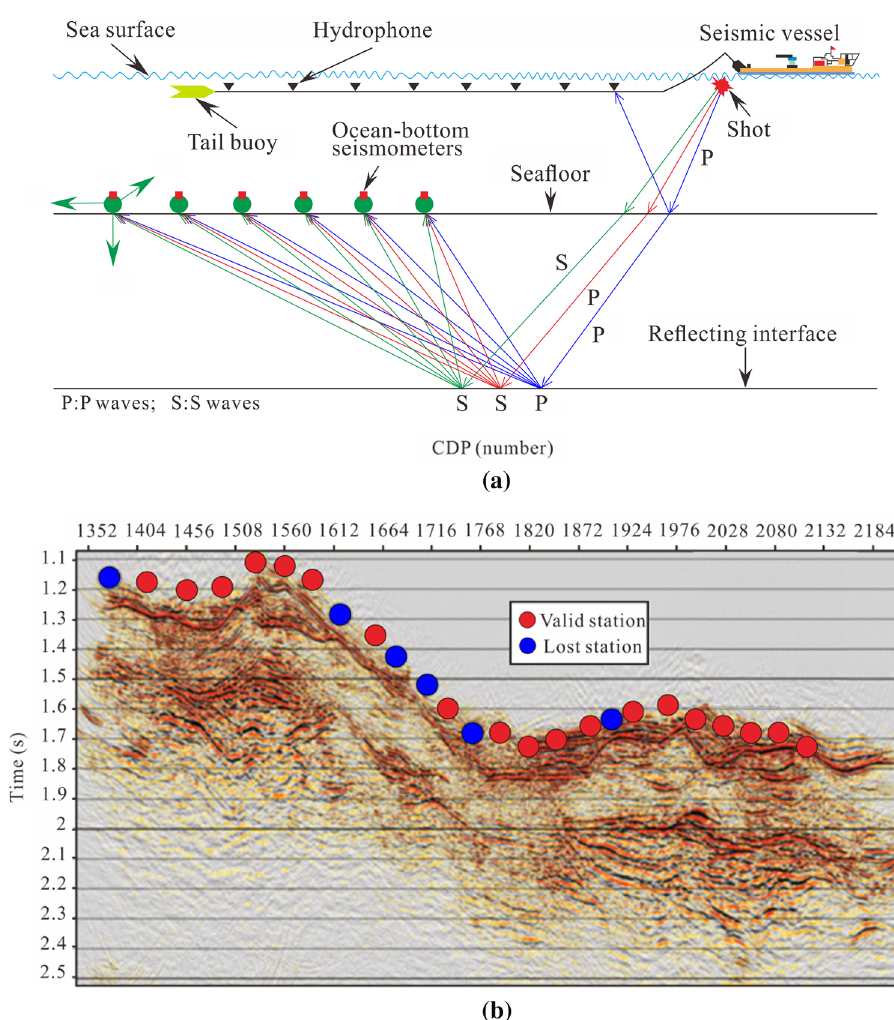
Fig. 8 a OBS principle and b example output (modified from Sha et al.